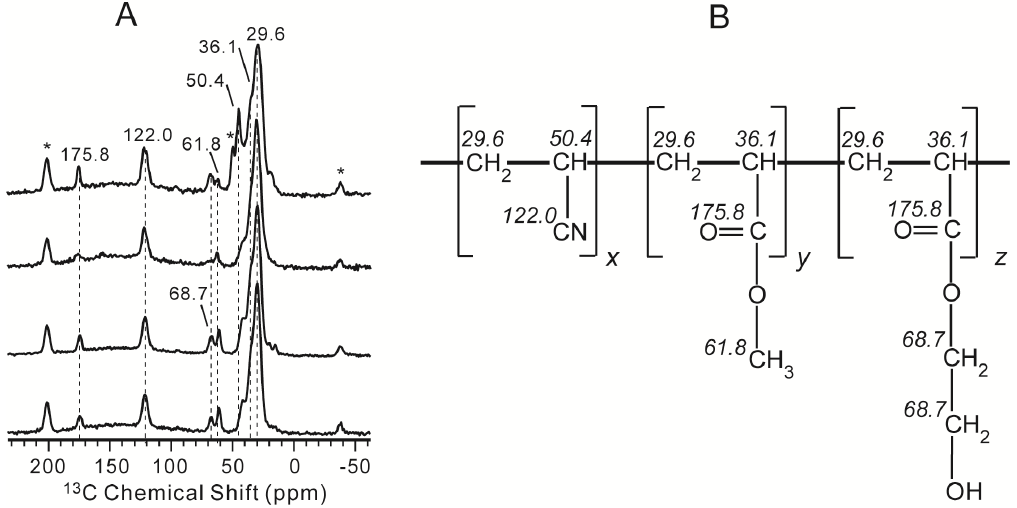
Figure 1. ( A ) 13 C CP/MAS NMR spectra of the NPBA acquired at room temperature and under 6 kHz MAS. Asterisks ( * ) represent spinning sidebands; ( B ) Schematic